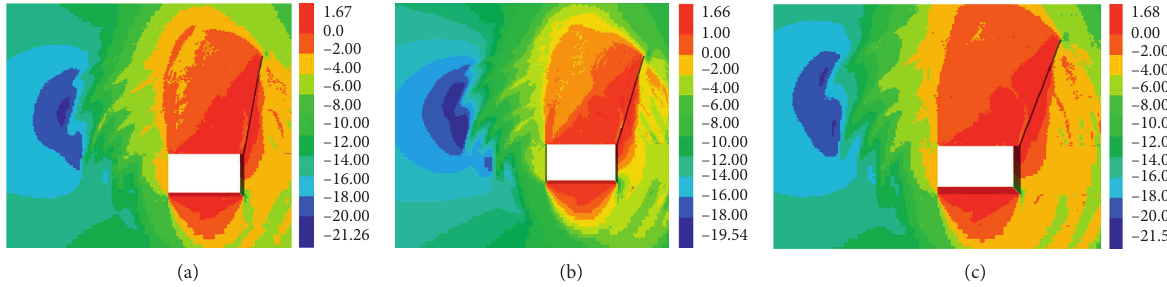
Figure 7: Vertical stress distribution under different roof cutting angles (MPa). (a) Roof cutting angle is 10 ° . (b) Roof cutting angle is 15 ° . (c) Roof cutting angle is 20 °